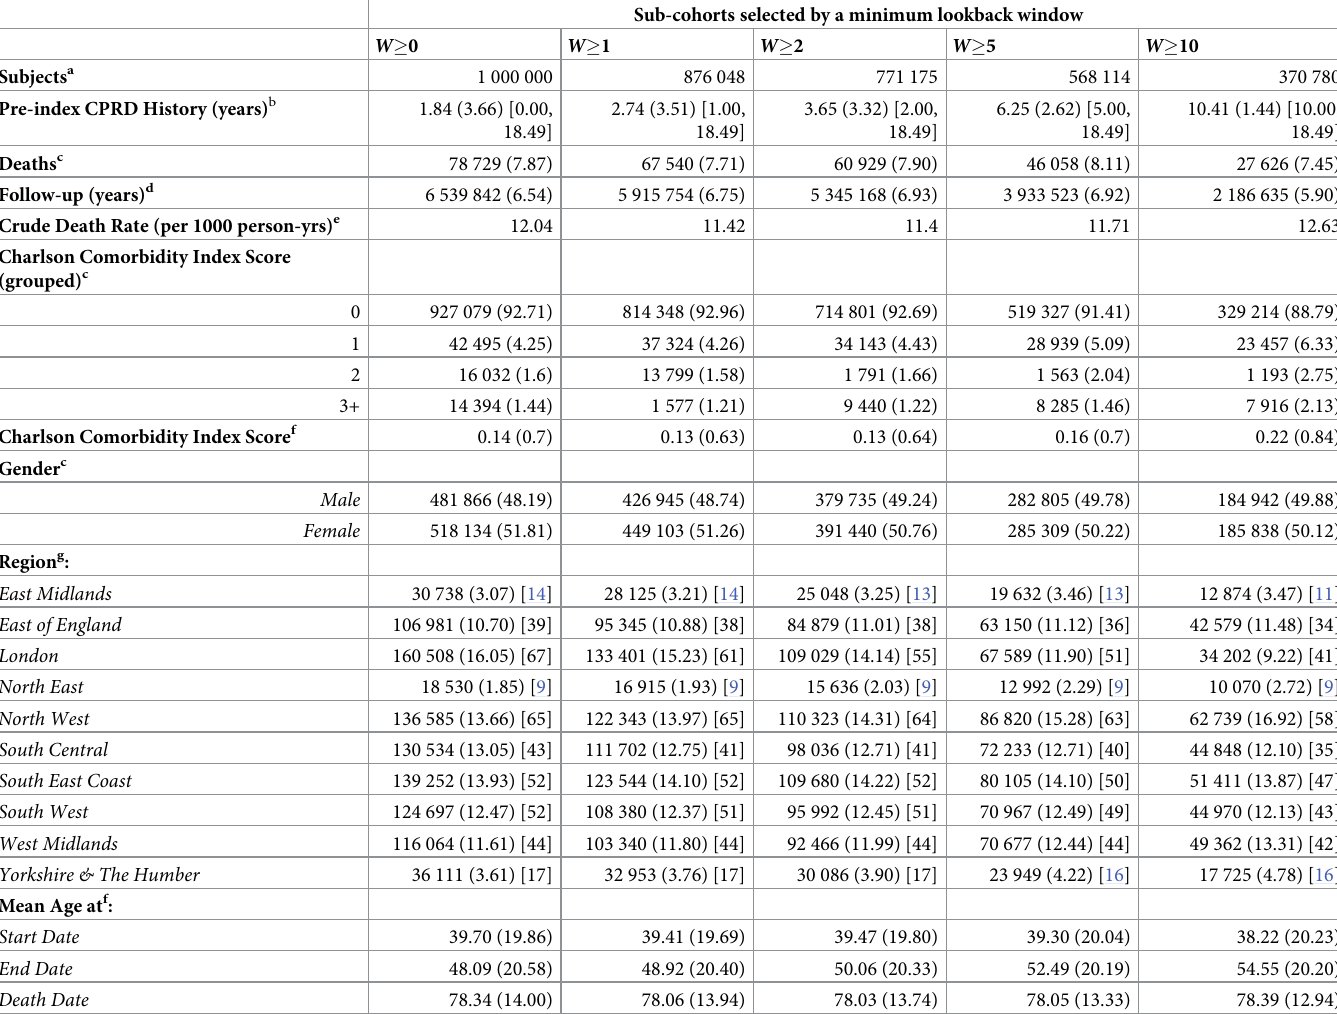
Table 1. Patient characteristics of the full cohort ( W � 0) and four sub-cohorts selected by a minimum lookback window